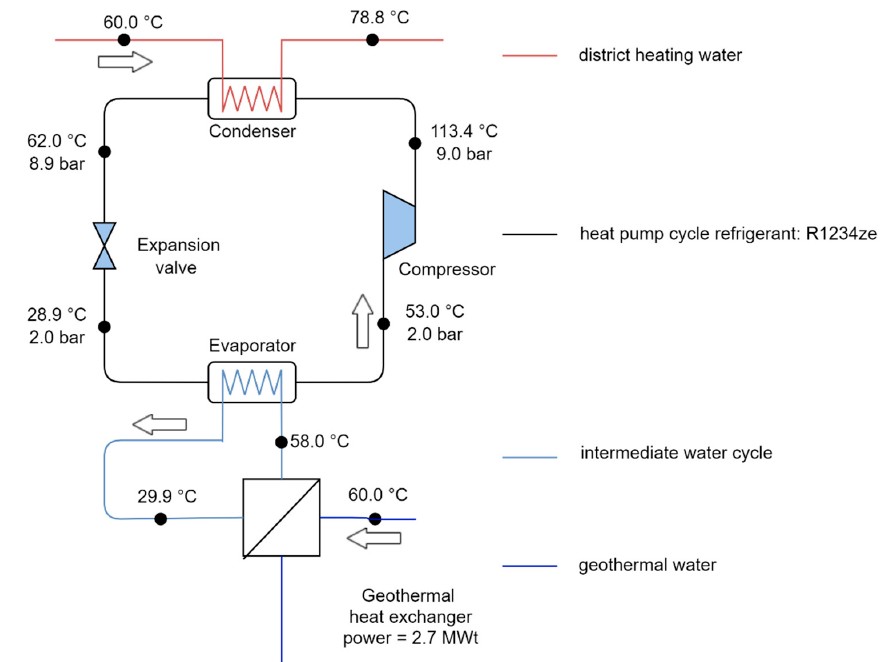
Figure 5. Scheme of the basic variant.